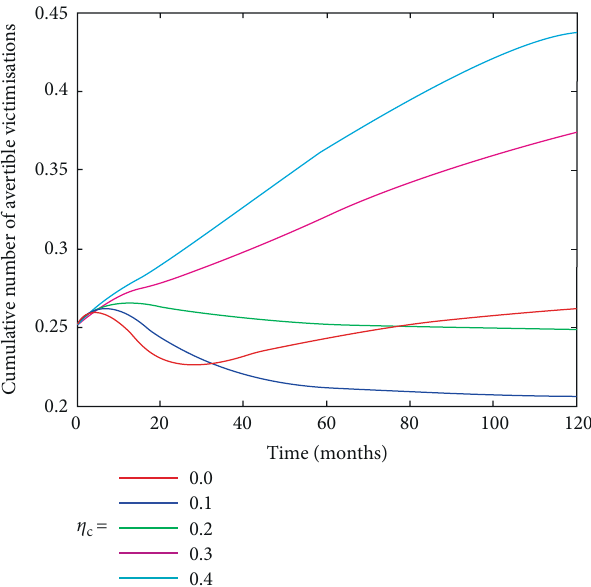
and Figure 8: Simulation of model (4) showing the effect of varying the 𝜏 2 ( Crime-induced death ) on the density of victimisation/ values of 𝜂 𝐶 victims as a function of time. Other parameter values used are as in Table